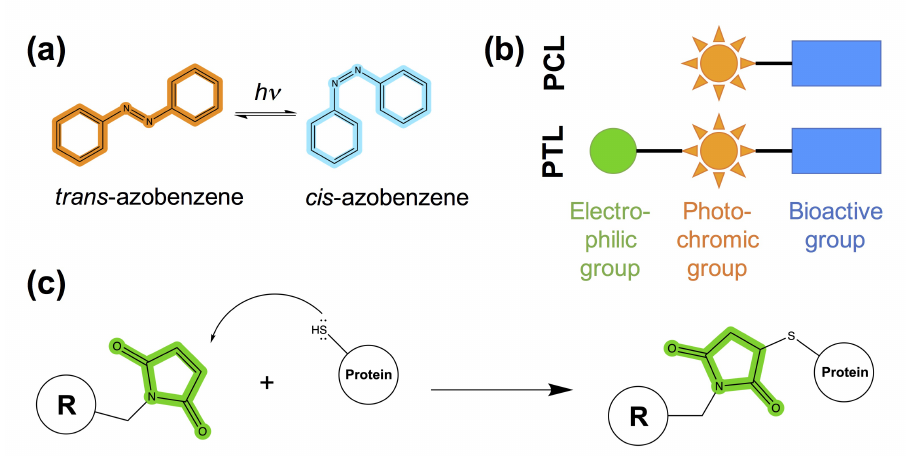
Figure 1. Chemical toolbox for the design of photoswitchable ligands. ( a ) Chemical structure of azobenzene, the most commonly used photochromic group, showing its trans-cis photoisomerization. ( b ) Modular design of photoswitchable ligands, either soluble photochromic ligands (PCLs) or photochromic tethered ligands (PTLs). ( c ) Covalent bond formation between the typical tethering protein residue, cysteine (shown here by its sidechain thiol group) and a common electrophile group included in PTLs, maleimide (colored in green); the rest of the PTLs are represented as a substituent